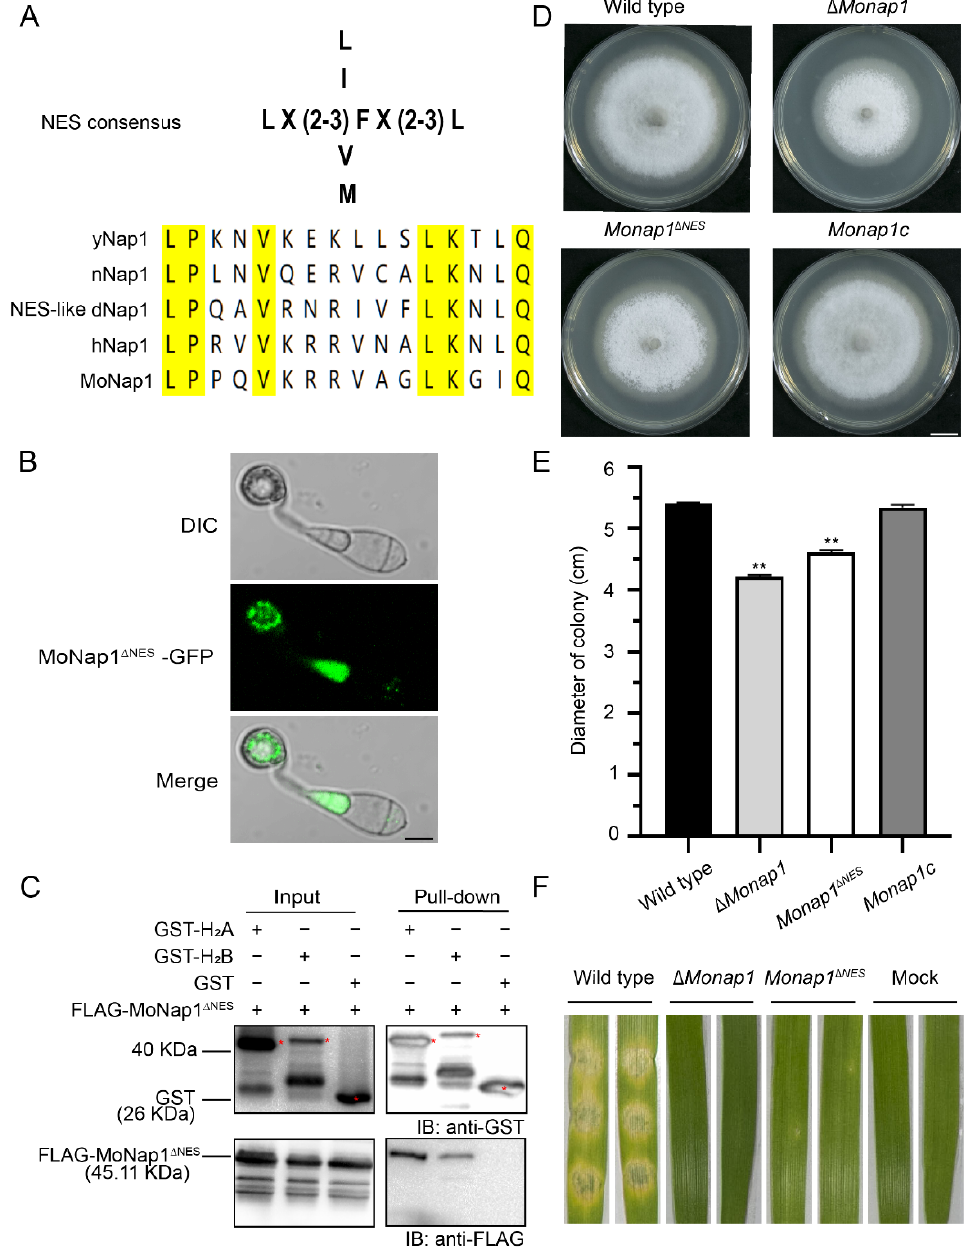
Figure 10. The NES region is not involved in H 2 A/H 2 B binding but is indispensable for growth and pathogenicity. ( A ) NES-like sequences of NAP1. The NES-like sequences of yeast Nap1 (yNap1), nematode Nap1 (nNap1), Drosophila Nap1 (dNap1), human Nap1 (hNap1) and MoNap1 are aligned. Yellow highlights indicate conserved amino acids. ( B ) Fluorescence signals of MoNap1 ∆ NES -GFP in appressoria. Bar, 5 μ m. ( C ) Pull-down results between FLAG-MoNap1 ∆ NES and GST-H 2 A and GST-H 2 B in E. coli BL21. FLAG-MoNap1 ∆ NES was detected in GST-H 2 A and GST-H 2 B eluents but not in GST eluents. Red asterisks represent the bands of GST-H 2 A (41.27 kDa), GST-H 2 B (41.82 kDa), and GST (26 kDa). ( D ) Colonies of the wild type and Monap1 ∆ NES . Bar, 1 cm. ( E ) Mycelial growth (cm) of the wild type and Monap1 ∆ NES colonies. n = 5 independent biological replicates. Error bars represent the standard deviations. The data were analyzed by GraphPad Prism 8.0 and significant differences compared with the wild type were estimated by multiple t tests: ** p < 0.01. ( F ) Disease symptoms of leaf explants of barley inoculated with mycelial plugs from the wild-type and Monap1 ∆ NES strains. The pictures were photographed at 4